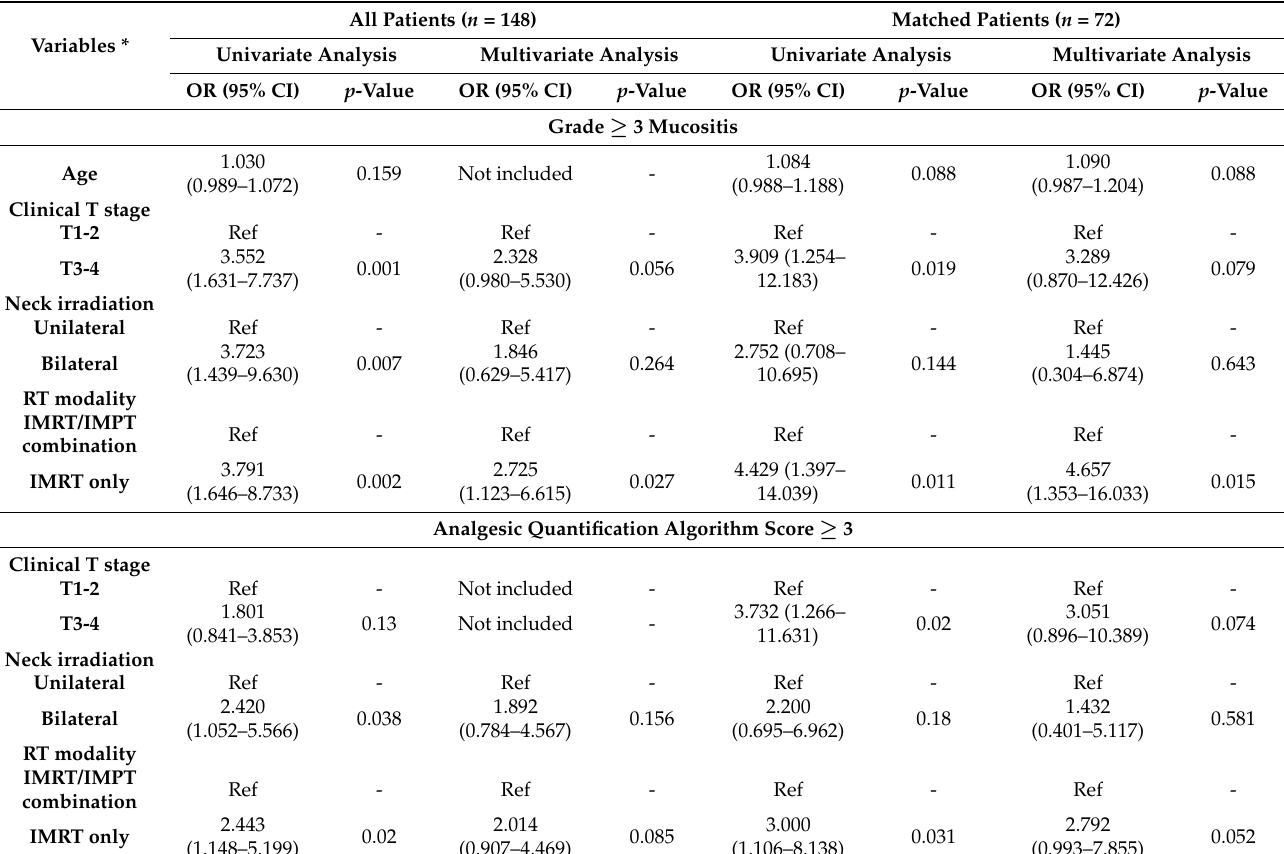
Table 3. Univariate and multivariate logistic regression for grade ≥ 3 mucositis and analgesic quantification algorithm score ≥